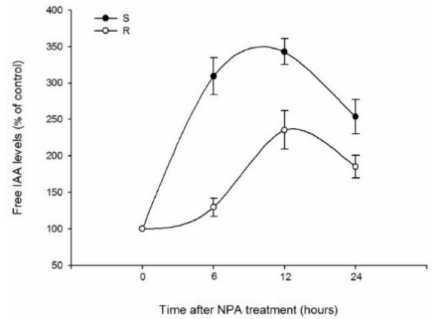
Figure 4. IAA contents in root tips were measured in S (susceptible, JNNX-S) and R biotypes (resistant, SSXB-R) after treatment with 1-N-naphthylthalamic acid (NPA) (100 µ M) at 0 h, 6 h, 12 h and 24 h. Data are the mean values of at least three biological replicates. The standard errors of the means are described by vertical